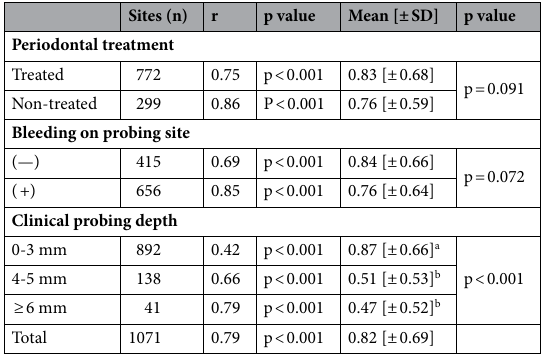
Table 1. Results showing the number of sites in each group, Pearson’s correlation coefficients and the mean differences between GD and PD. r = Pearson’s correlation coefficient. Bonferroni post t test, significant difference compared to 0–3 mm group (a > b, p < 0.001).